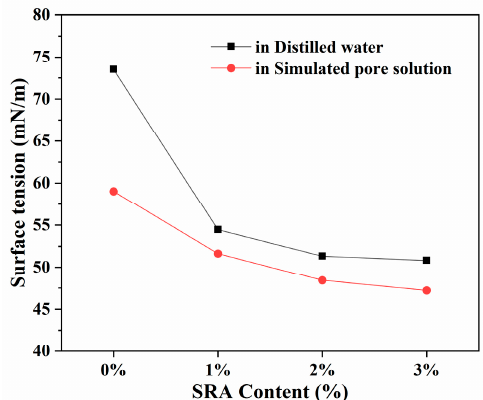
Figure 9. Effect of SRA on the surface tension of water and simulated pore solution.